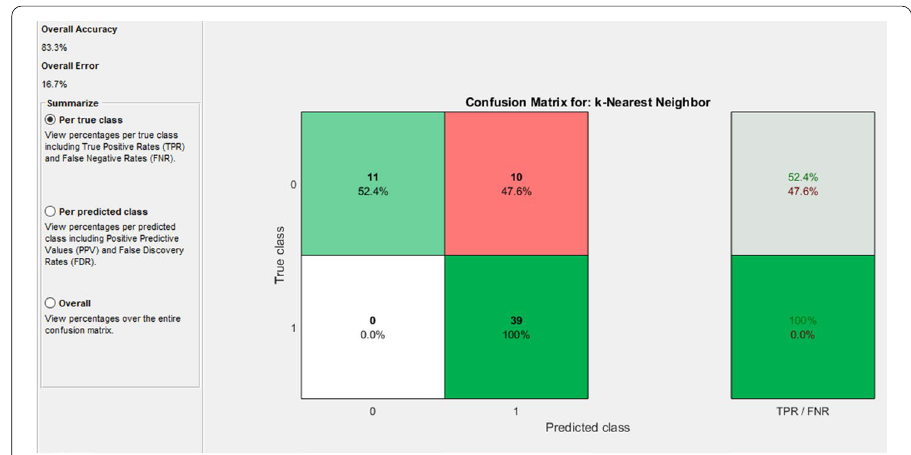
algorithm, using 10-fold cross-validation parameter, was used to classify the experiment.